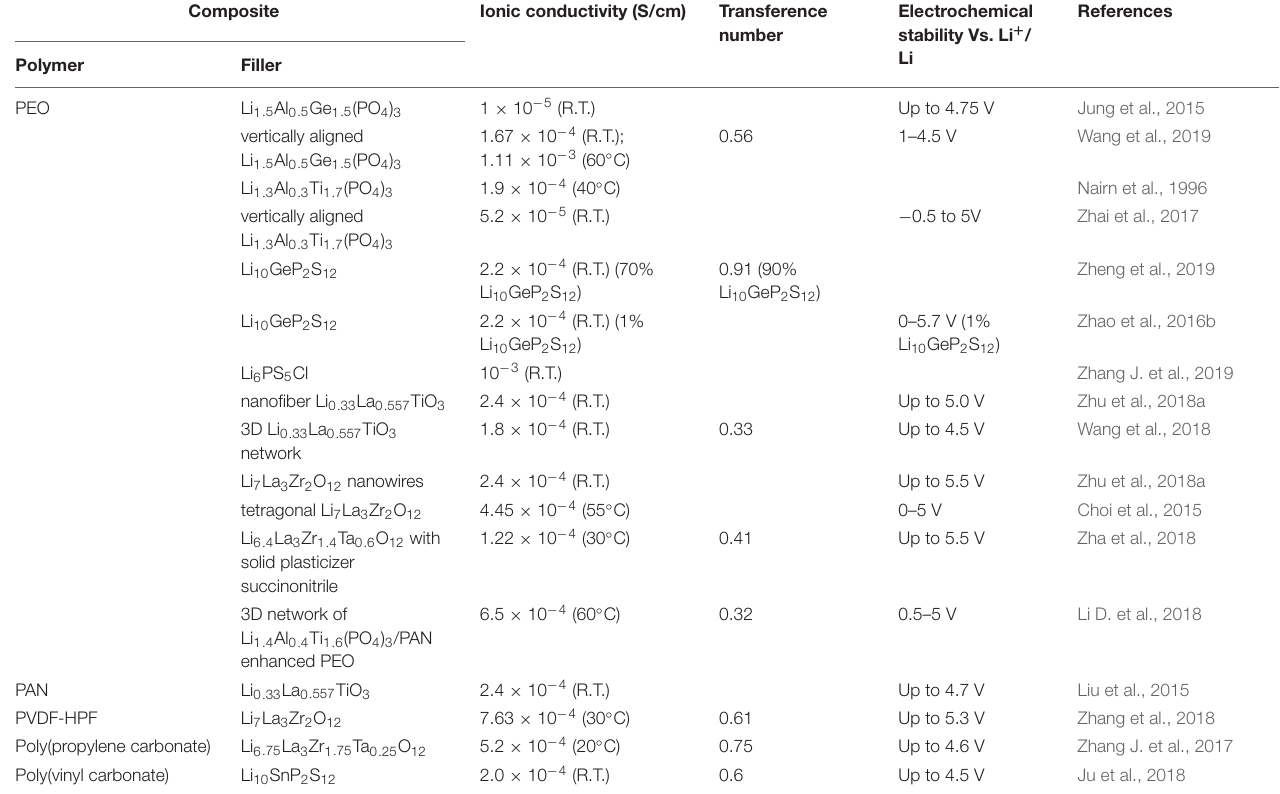
TABLE 1 | Summary of recent HSE